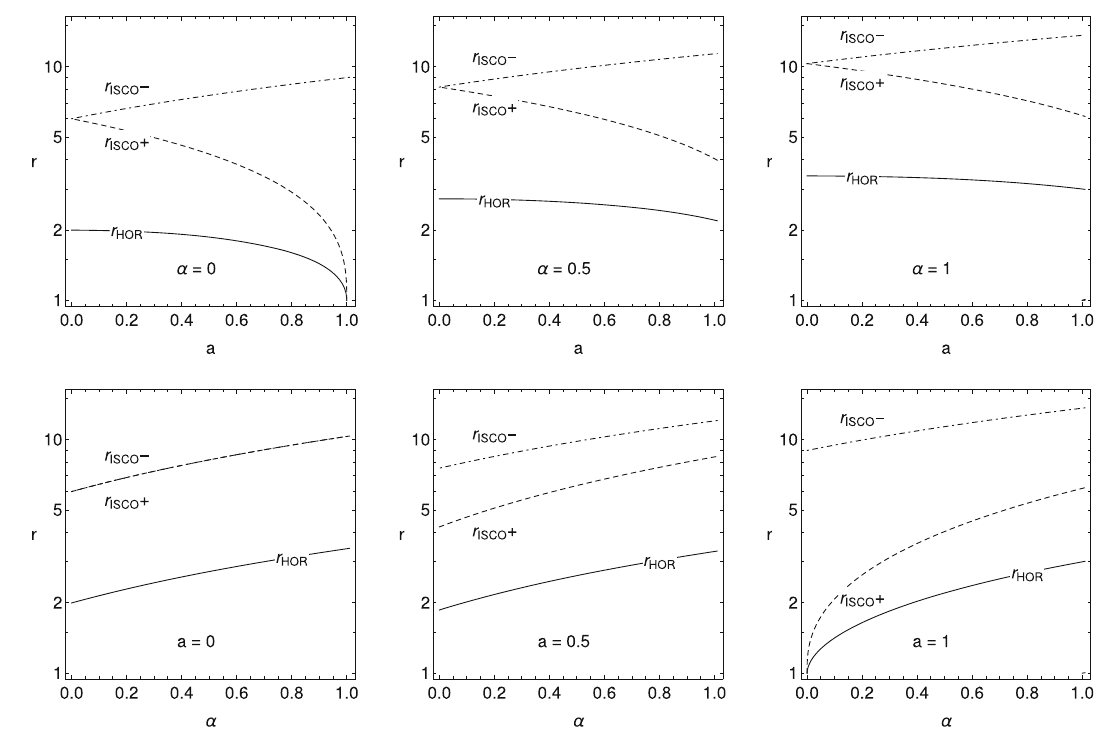
Fig. 1 Position of ISCO and horizon in Ker-MOG BH. The first row is plotted for different values of α while second row is plotted for different values of rotation parameter